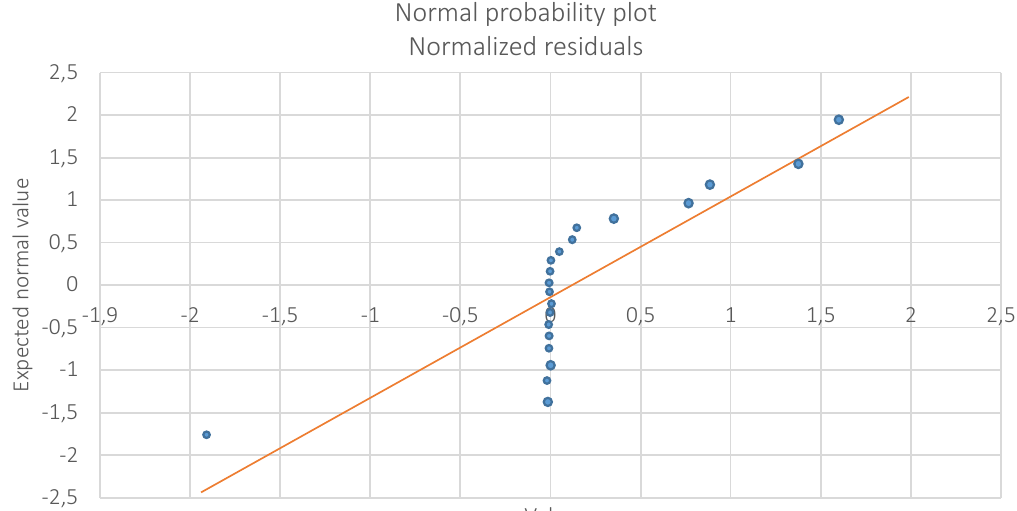
Figure 2. Checking the adequacy of the model of relationships between NPLs of banking institutions, profitability and financial stability of the Ukrainian banking